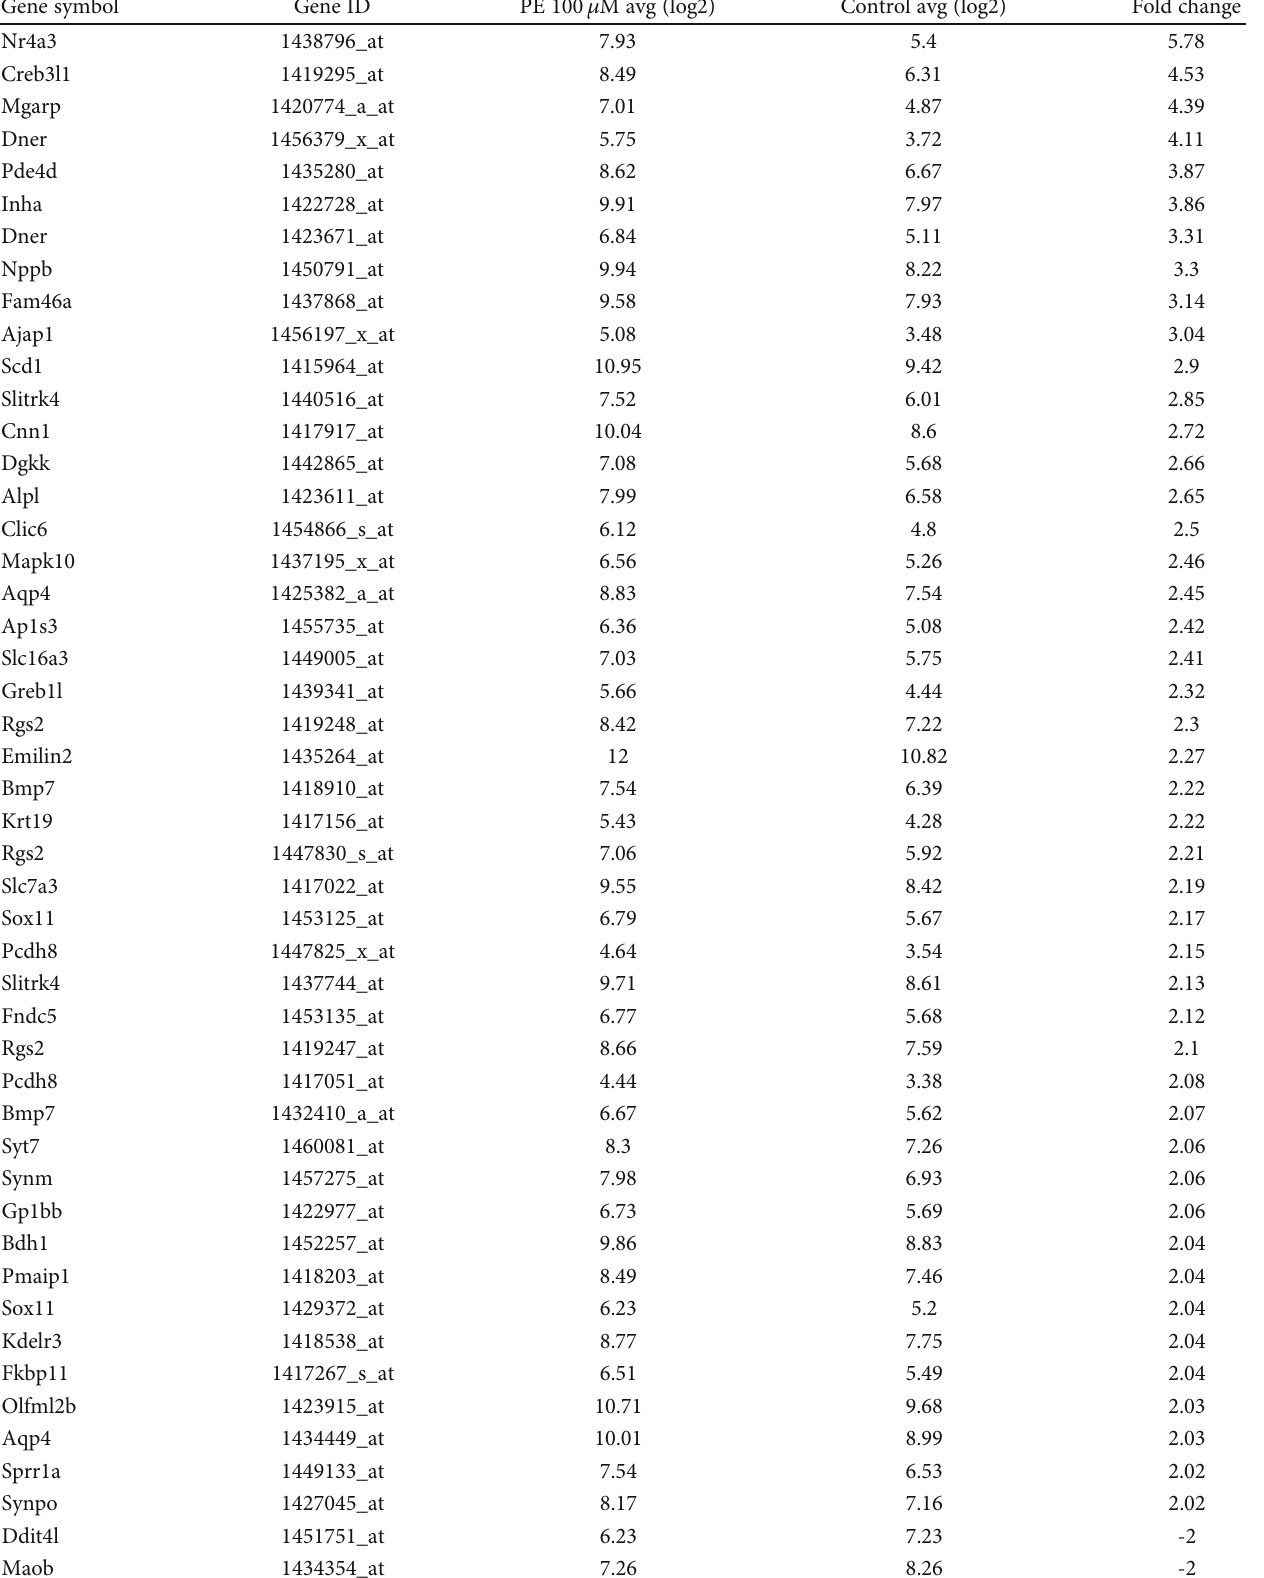
Table 1: Di ff erential gene expression in PE-treated